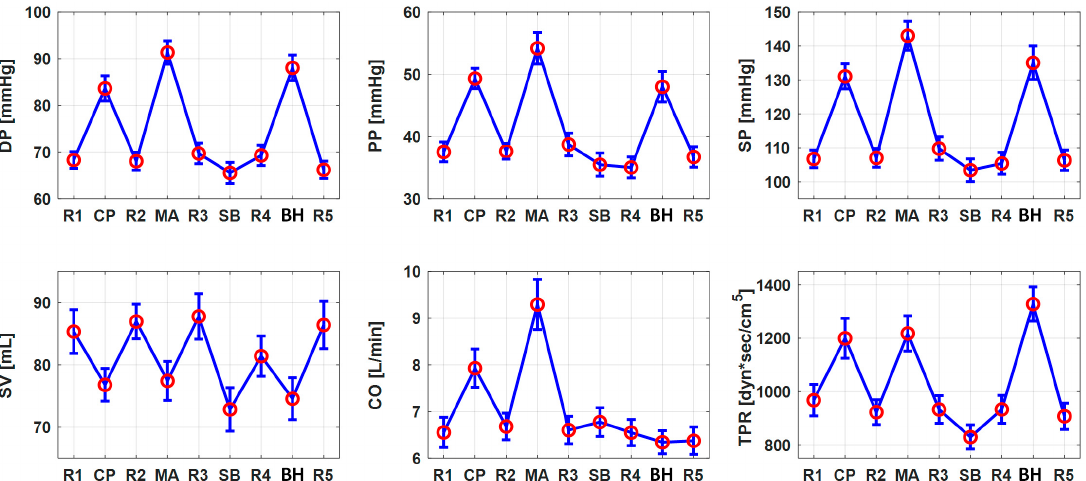
Figure 3. Group-average changes in the cardiovascular parameters in response to hemodynamic interventions (mean ± standard error (SE)).